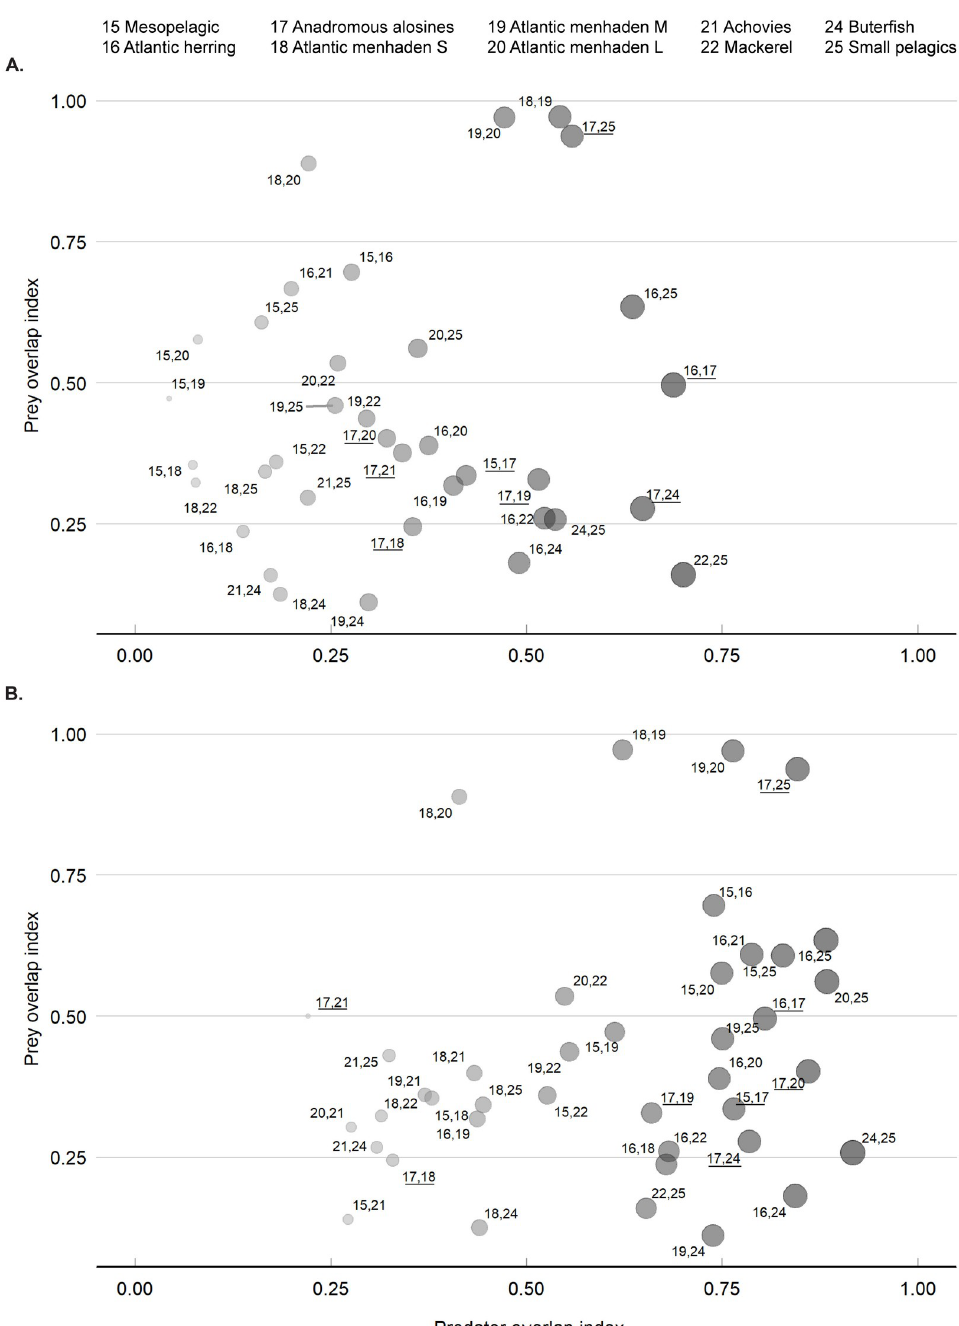
Fig 4. Niche overlap index plot of the forage fish functional groups. (A) Contemporary Alosine Biomass model. (B) Restored Alosine Biomass model. The color gradient and size of nodes are representing the predator overlap index number. Numbers refer to the functional groups, anadromous alosine are represented by underlined numbers.